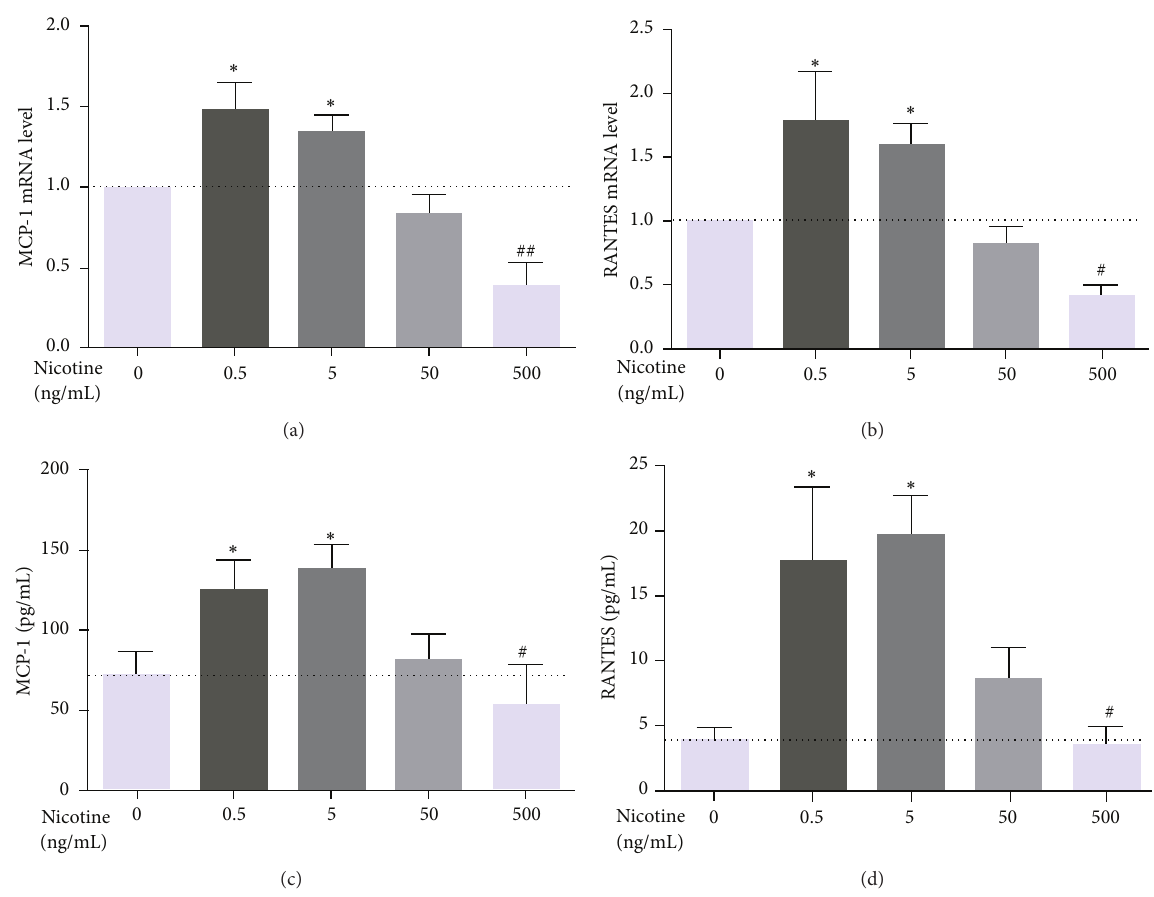
Figure 5: Expression of MCP-1 and RANTES under a concentration gradient of nicotine in MOVAS cells. Cellular mRNA expression levels of MCP-1 and RANTES (a, b) and the levels of secreted MCP-1 and RANTES in the supernatant (c, d) are shown. MCP-1 and RANTES expression as well as secretion was induced by nicotine in a dose-dependent fashion. The strongest expression was observed for 0.5 ng/mL and 5 ng/mL nicotine. Data are from independent triplicate experiments. ∗ 𝑃 < 0.05 and ∗∗ 𝑃 < 0.01 versus control; # 𝑃 < 0.05 and ## 𝑃 < 0.01 versus the group treated with 5ng/mL